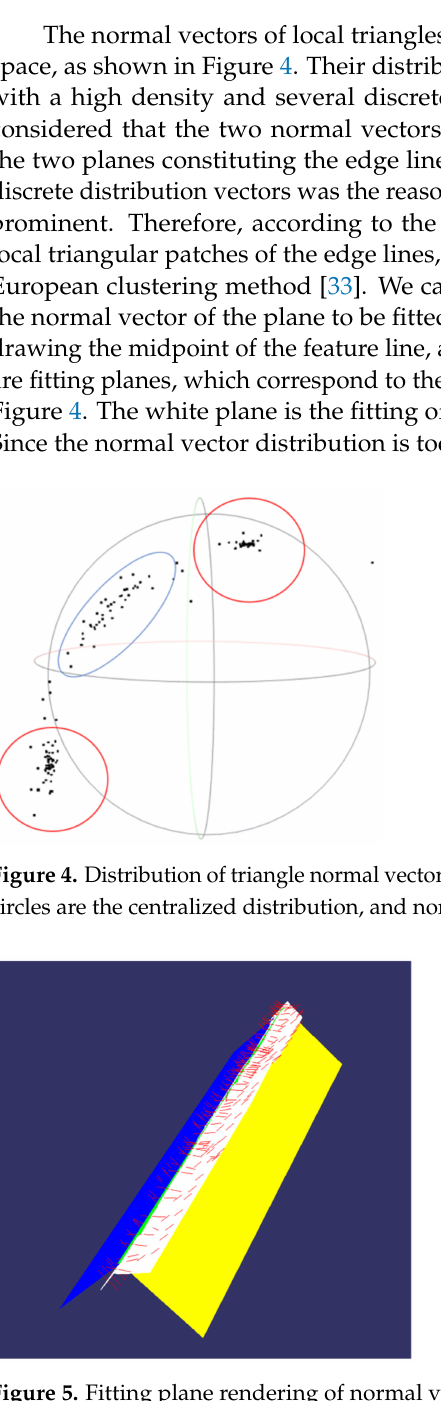
Figure 5. Fitting plane rendering of normal vectors in two main directions after removing discrete normal vectors. The yellow and blue planes are fitting planes of the main normal vectors, the white plane is the fitting plane of the discrete normal